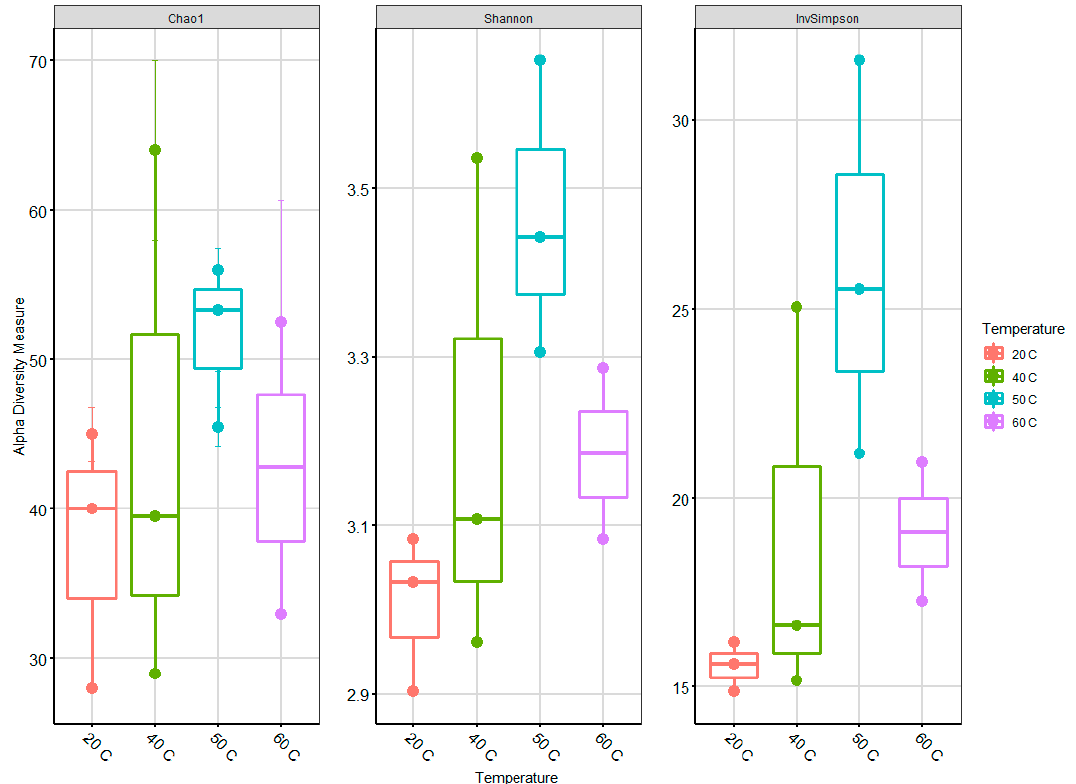
Figure 4. Methanogenic archaeal alpha diversity. Alpha diversity as estimated by species richness (Chao index), the Shannon and InvSimpson diversity indices based on amplicon sequence variants (ASVs) abundance data from mcrA gene sequencing.